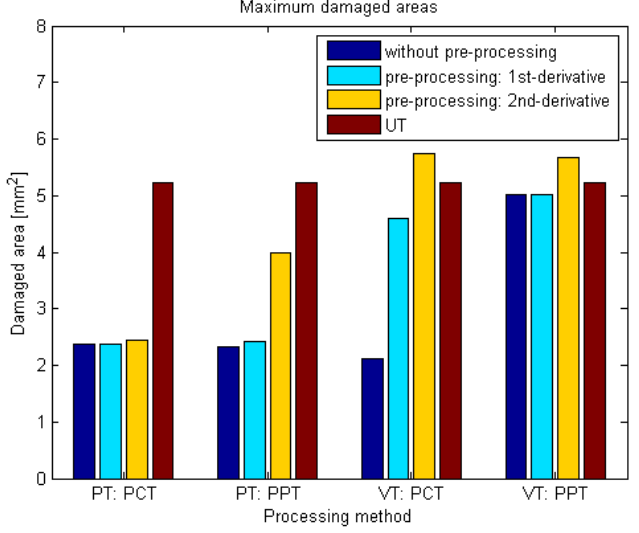
Figure 10. Maximum damaged areas measured in CFRP